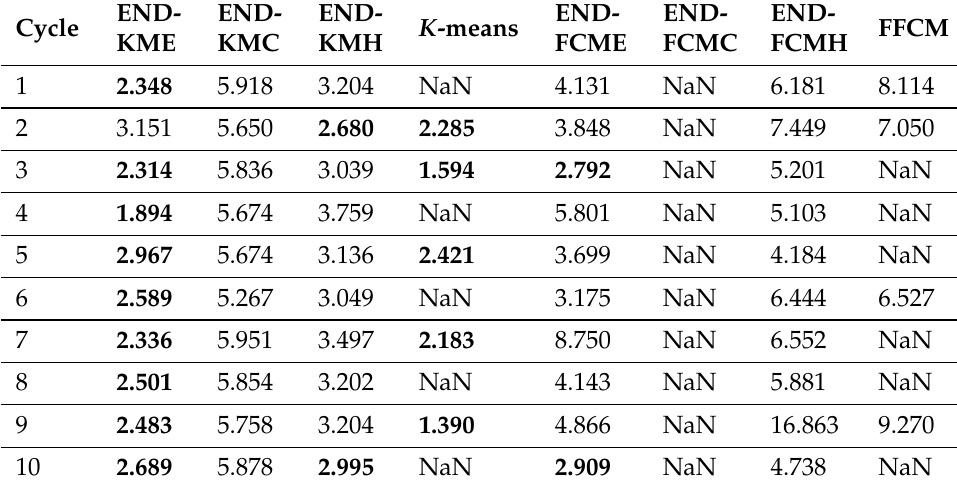
Table 4. DB index clustering test results (best performance in